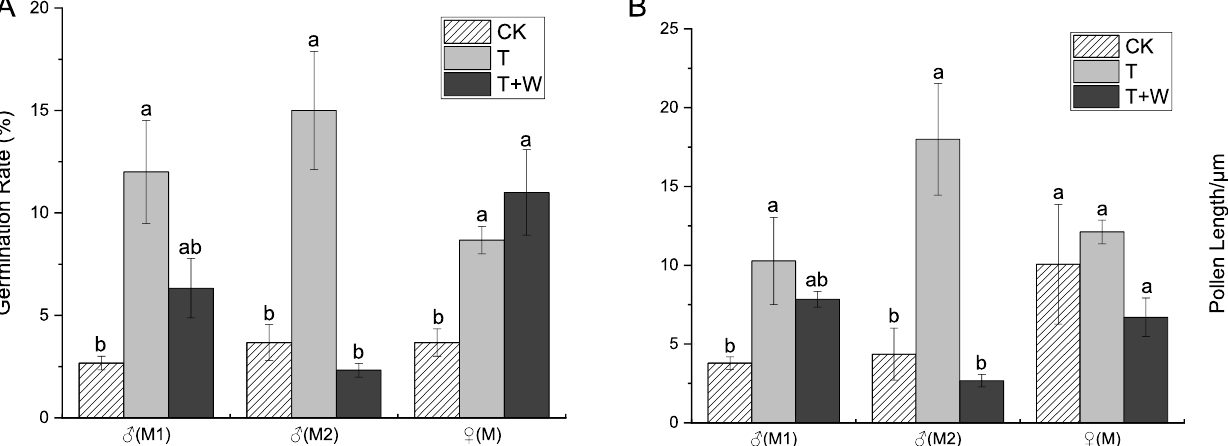
Figure 2. Pollen germination rate ( A ) and tube length ( B ) of different batches after nTiO 2 treat- ment. M1: first batch of male flowers. M2: second batch of male flowers. M3: female flower. CK: 0 mg/L nTiO 2 . T: 150 mg/L nTiO 2 . T + R: 150 mg/L nTiO 2 + Water Brush. Different letters indicate statistical differences between treatments ( p ≤ 0.05).